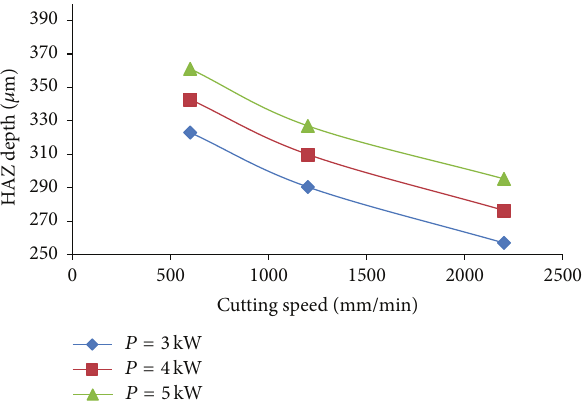
Figure 7: Effect of laser power and cutting speed on HAZ depth ( 𝐷 = 1 mm).